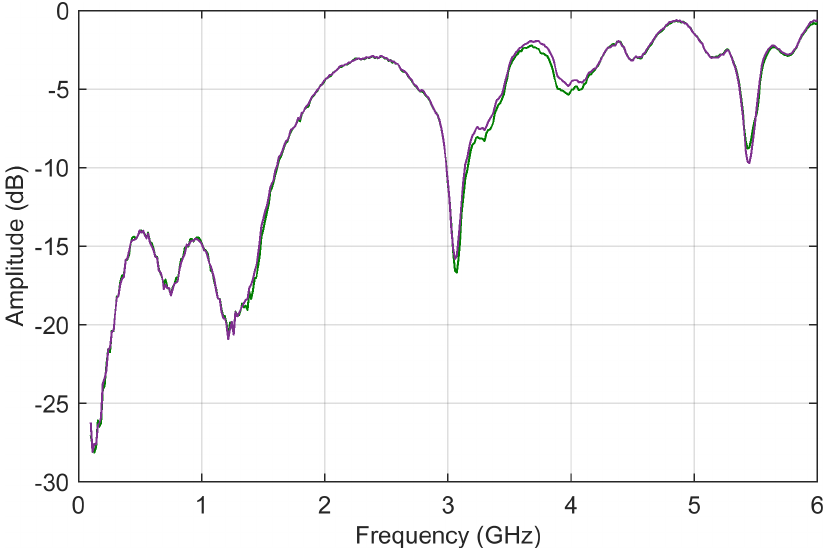
Figure 11. S 11 input data curves 1A and 1B in logarithmic scale (dB) of test case 2. ADM i and FDM i amplitudes for analytical and MCM calculations are shown in Figure 12, accompanied by an estimate of the relative amplitude error.